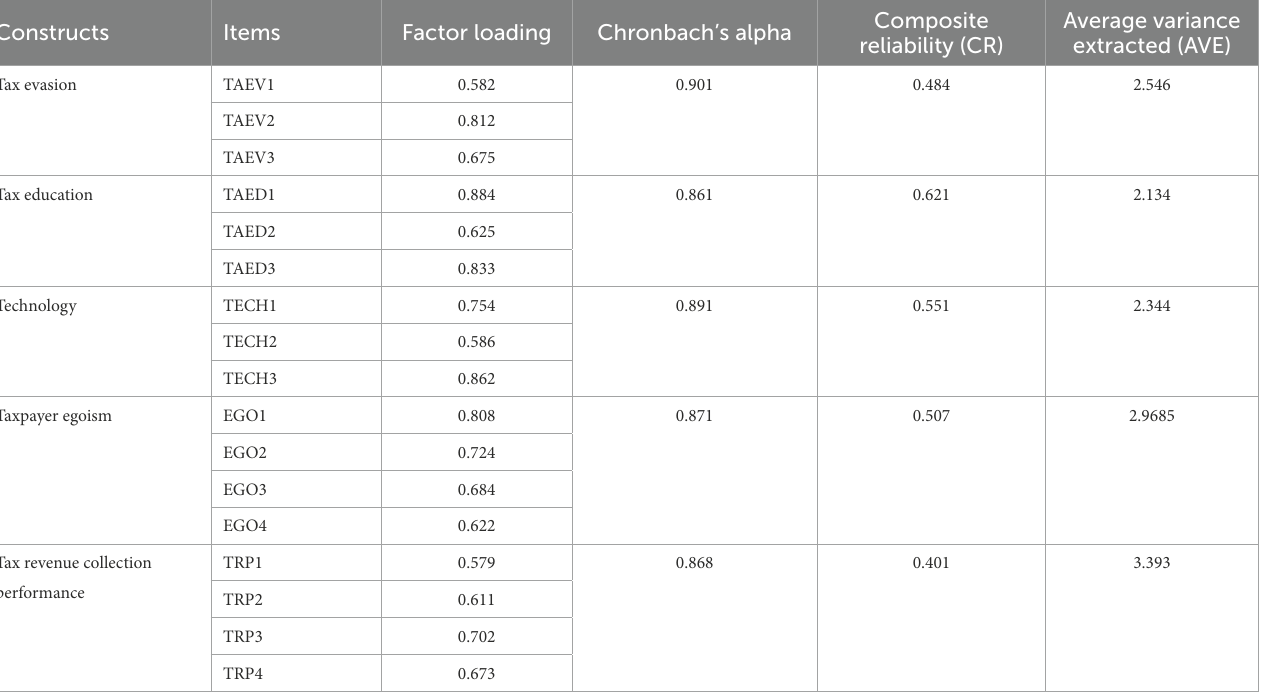
TABLE 1 Results of reliability and validity